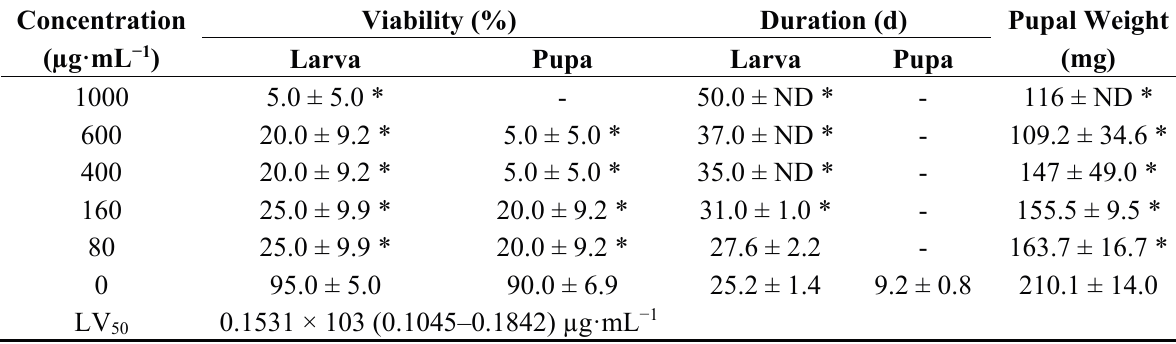
Table 3. Insecticide and insectistatic activities of β -caryophyllene against S. frugiperda